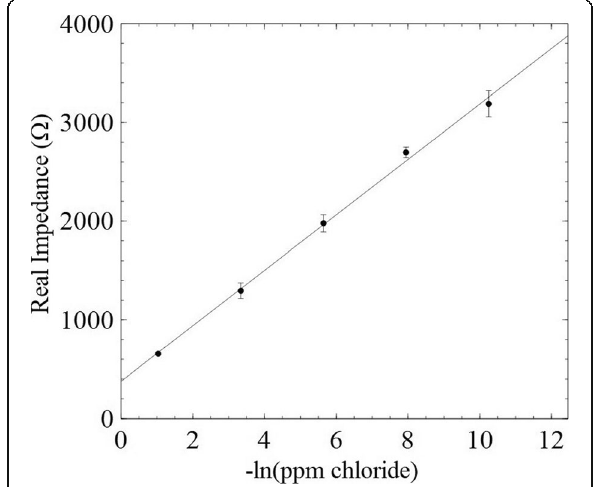
Fig. 4 Real resistance ( Ω ) vs. – ln ppm chloride